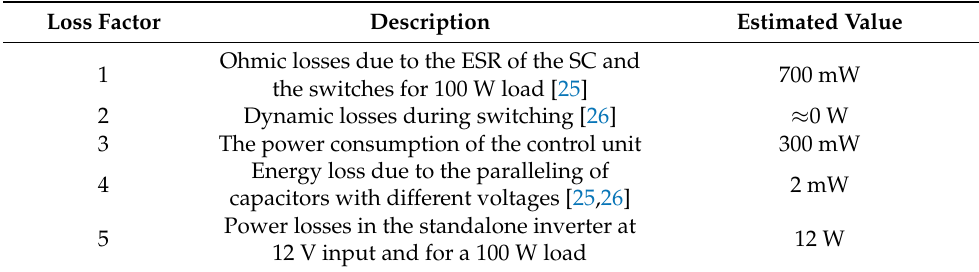
Table 3. Estimated power losses in the 24VDC-120VAC SCAWI-PV inverter. Loss Factor Description Estimated